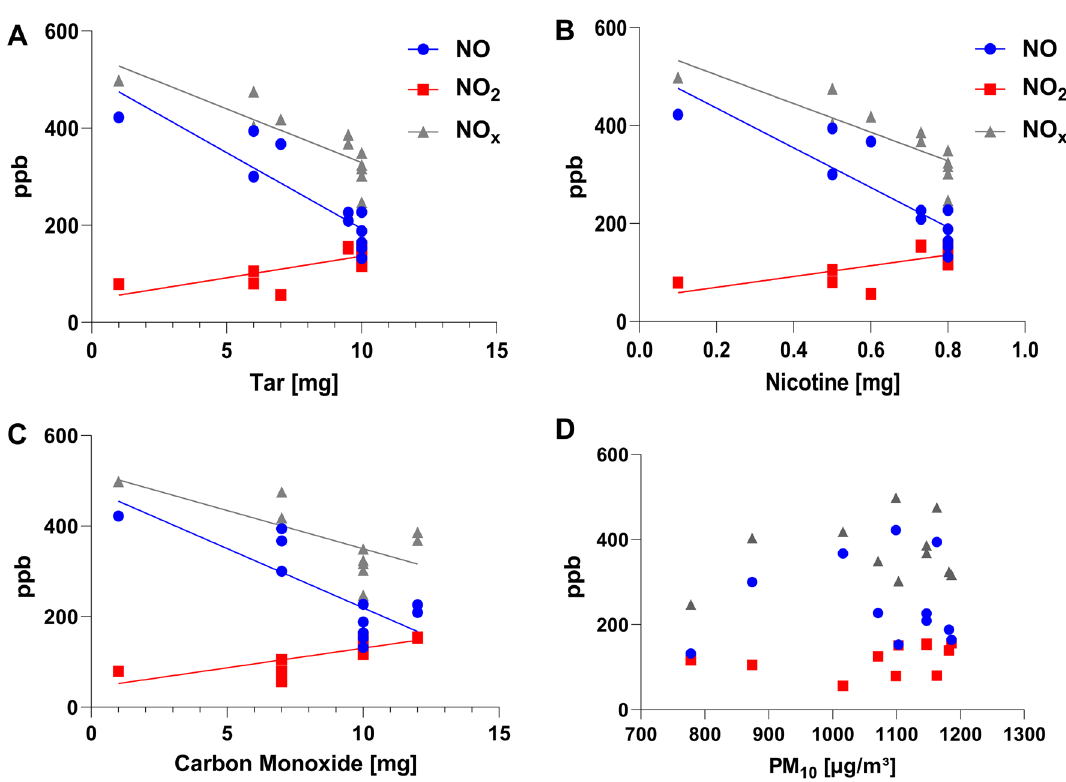
Figure 2. Association between nitric oxide (NO), nitrogen dioxide (NO 2 ), and nitrogen oxides (NO x ) concentrations and concentrations of tar ( A ), nicotine ( B ), carbon monoxide (CO) ( C ), and particulate